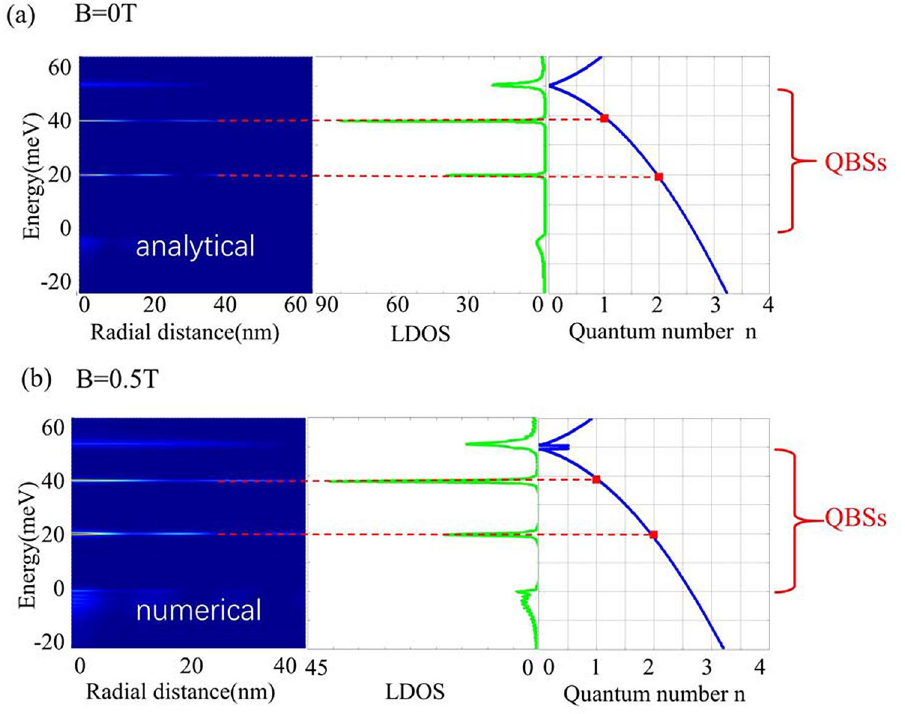
Figure 4. WKB analysis for quasi-bound states in CNPJ of BLG ( a ) without and ( b ) with magnetic field. The blue curve is from quantization condition Eq. (38), the red dots on blue curve corresponds to the peaks of LDOS, justifying the consistency between WKB solution and analytical (numerical)